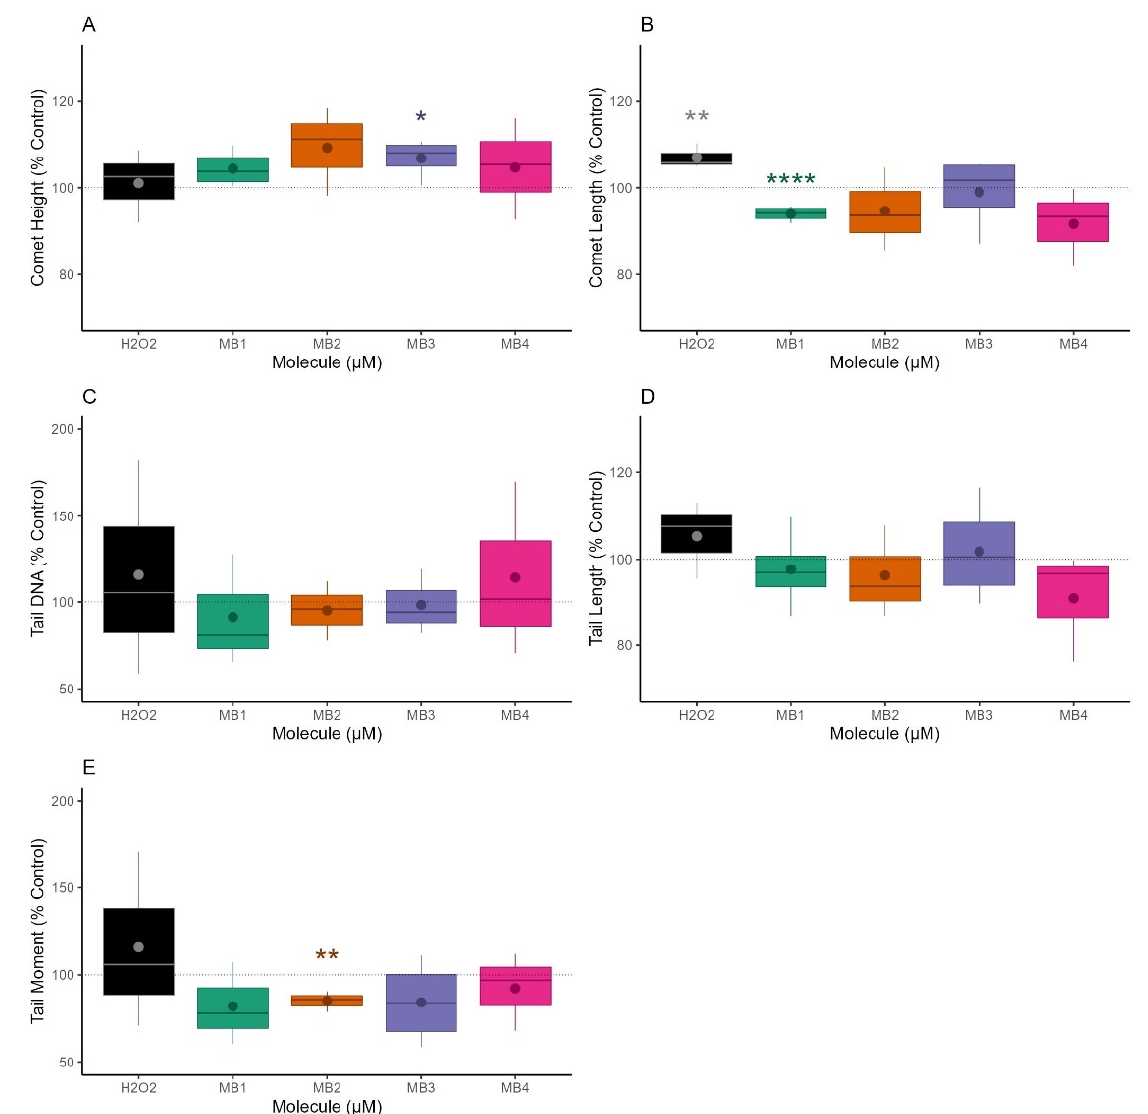
Figure 4. Effects of hydroxybenzoic-based mitochondriotropic antioxidants MB1-MB4 on DNA damage. Normal Human Dermal Fibroblasts (NHDF) were treated with MB1, MB2, and MB4 at 25 µ M and MB3 at 6.3 µ M for a period of 48 h. DNA damage was assessed using the comet assay. H 2 O 2 at 500 µ M was used as a positive control. The different parameters of Comet Height ( A ), Comet Length ( B ), Tail DNA % ( C ), Tail Length ( D ) and Tail Moment ( E ) in NHDF were quantified using Cell Profiler software. Results are expressed as a function of control (CTL = 100%) and represent the interquartile range (Q1–Q3), together with the (•) mean and ( − ) median of three independent exper- iments. Data outside the Q1–Q3 range are represented as data outliers (*). Statistically significant differences between control (CTL) and treated groups were evaluated using a t -test. **** p < 0.0001, ** p < 0.01 and * p < 0.05 compared to CTL (vehicle-treated cells).